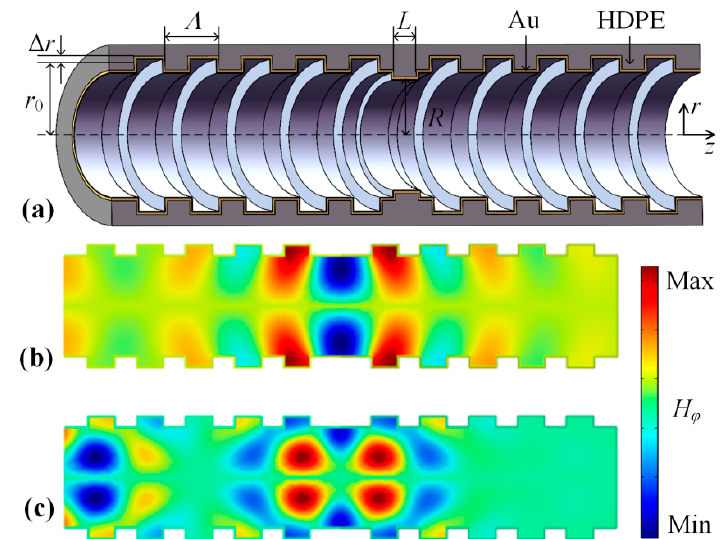
Figure 1. ( a ) Configurations of the proposed waveguide. The middle straight pipe contains the defect structure, where L and R are the length and the radius of the defect, respectively. ( b ) The magnetic field distribution at the peak frequency (0.462 THz) of the Bragg defect state. ( c ) The magnetic field distribution ( H ϕ ) at the peak frequency (0.695 THz) of the non-Bragg defect state (NBDS).